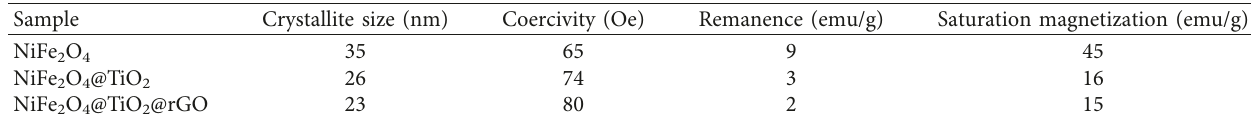
Table 2: Magnetic properties of core@shell